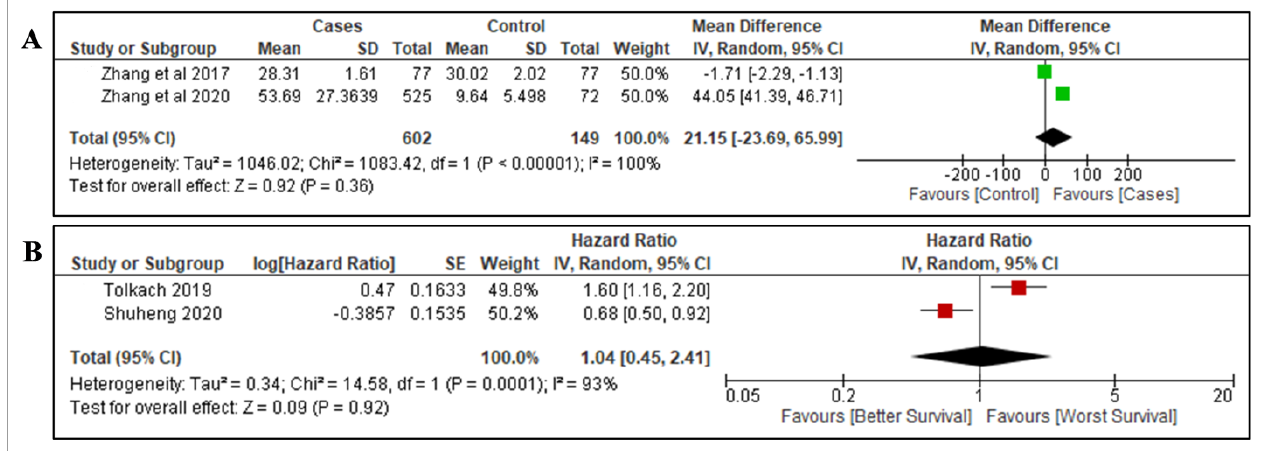
Figure 3. Forest plots of included studies on expression of apelin in RCC. ( A ) Expression of apelin in RCC versus adjacent normal tissue as a control [27,39]. ( B ) Apelin expression and OS in RCC. Mean difference, hazard ratio and 95% confidence intervals (95% CIs) were pooled using random effects meta-analysis. The squares indicate the effect size for each study (mean difference between control and RCC cases of apelin and HR of overall survival of apelin) and the length of the lines indicates the 95% CIs. The size of the square represents its weight in the analysis. The black diamond on the bottom of the forest plot indicates the overall weighted effect size. Abbreviations: I 2 = between-study heterogeneity; CI = confidence interval [37,38].